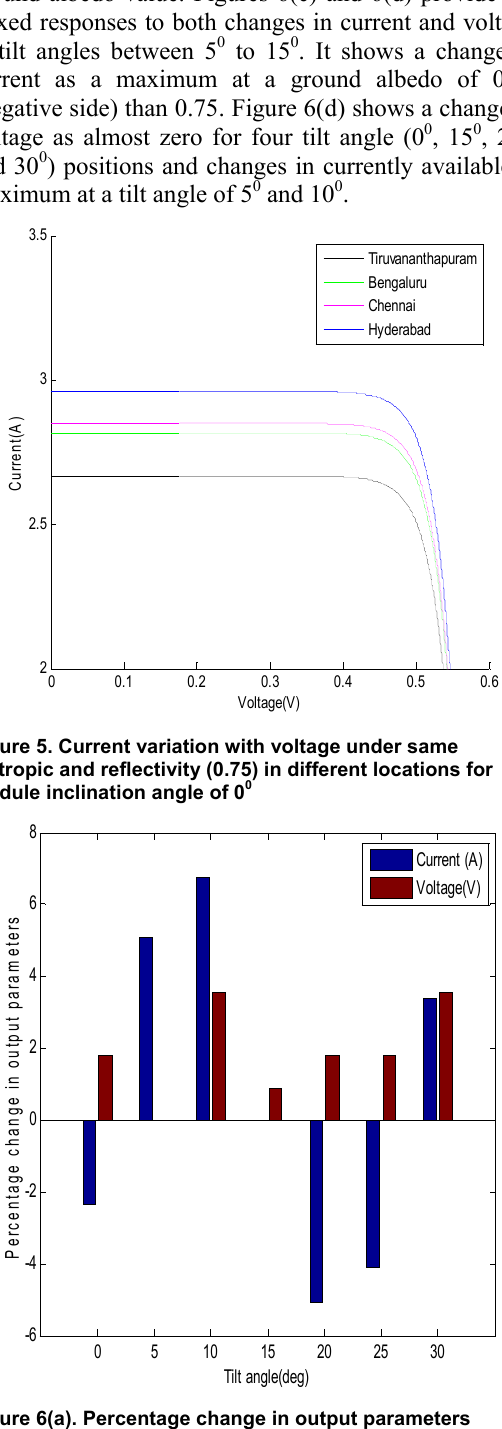
Figure 6(a). Percentage change in output parameters (Current and Voltage) with tilt angle for increases in ground albedo from 0.07 to 0.75 at